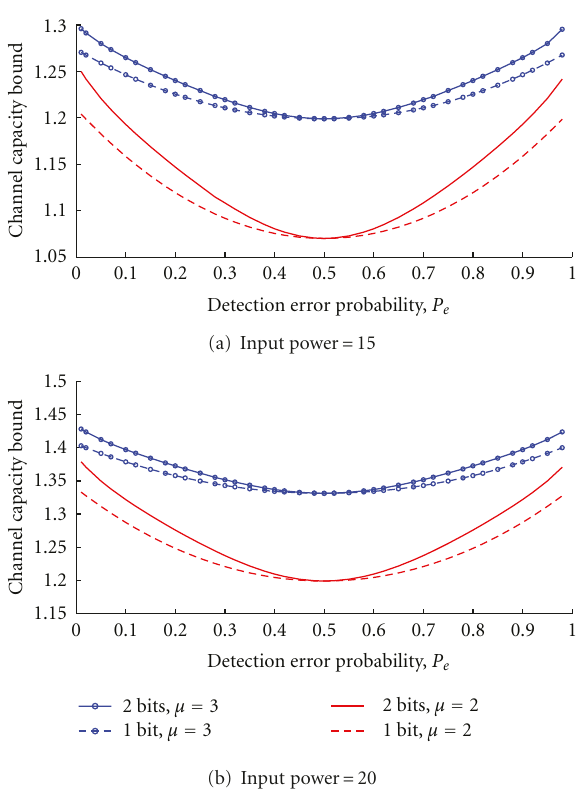
Figure 10: Channel capacity lower bound versus detection error probability. Quantization region detection model: p ( i | j ) = P m ij e (1 − P e ) ( N − m ij ) .